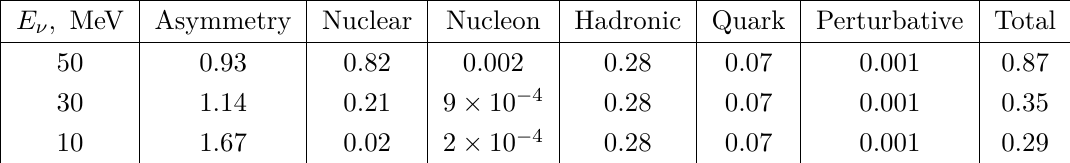
) /σ in % , on 40 Ar target and contributions to the − σ ν ν µ e µ . ν